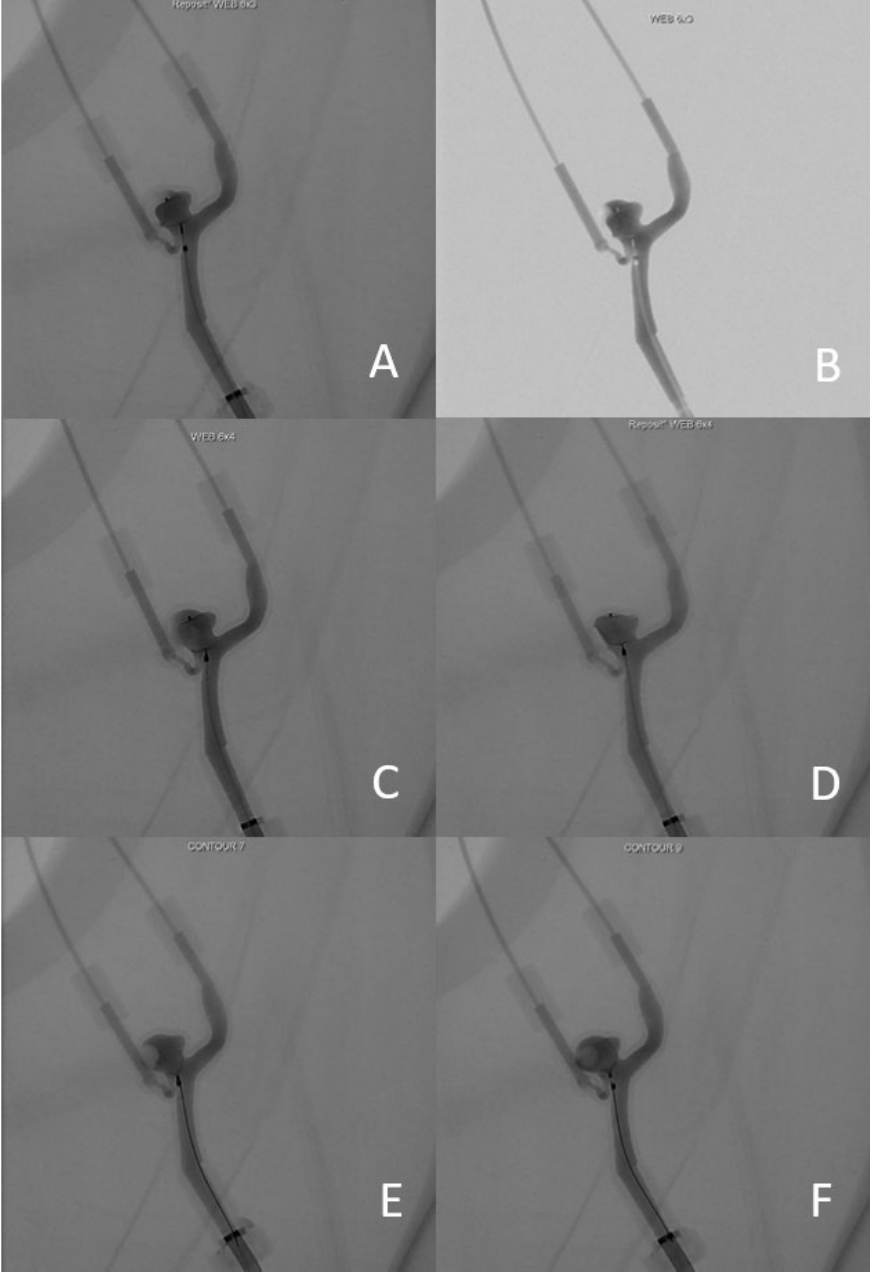
Figure 4. ( A ) angiography image of WEB 6-3 without subtraction; ( B ) angiography image of WEB 6-3 with subtraction; ( C ) WEB 6-4 position 1; ( D ) Web 6-4 position 2; ( E ) CONTOUR 7; ( F ) CONTOUR 9 .